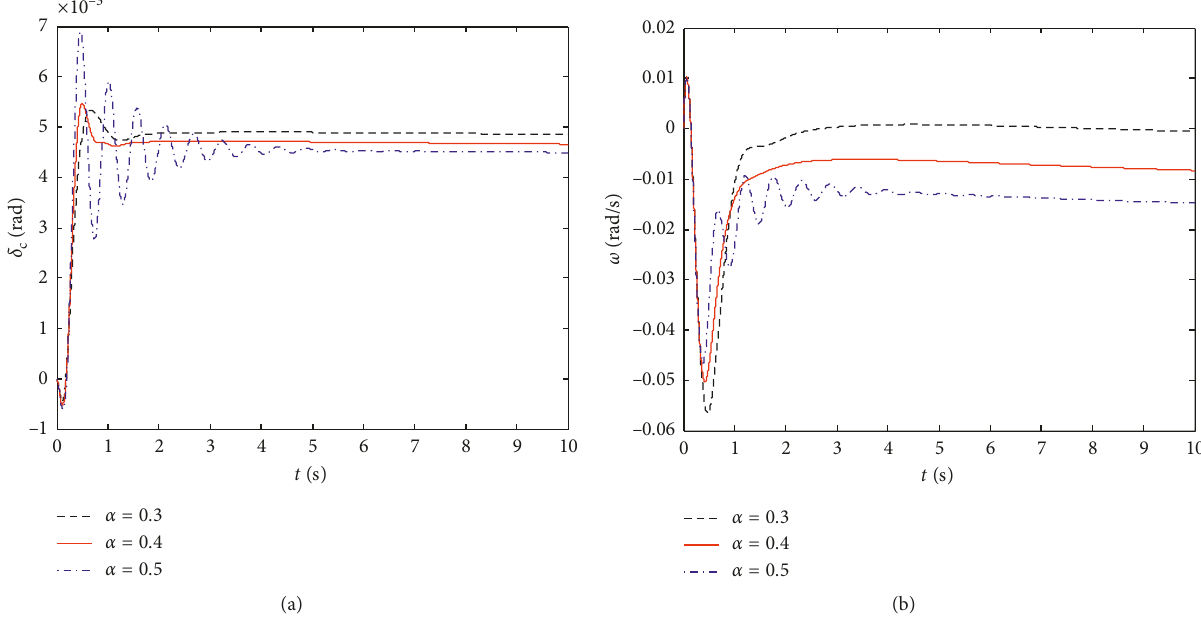
5 MPa. 0 (cid:30) 0.8 × 10